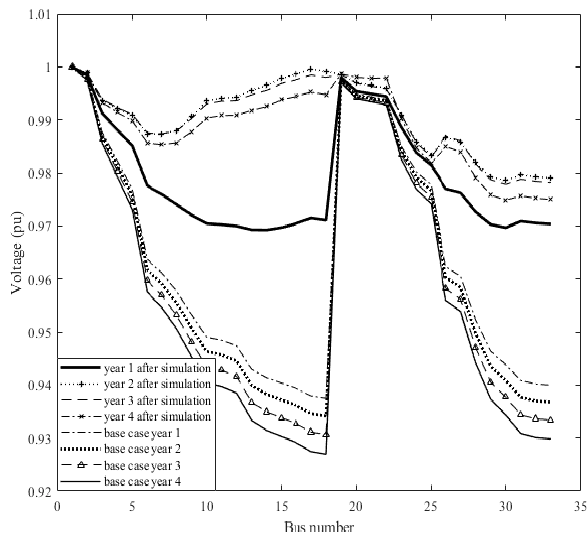
Figure 4. The average network voltage in different years.